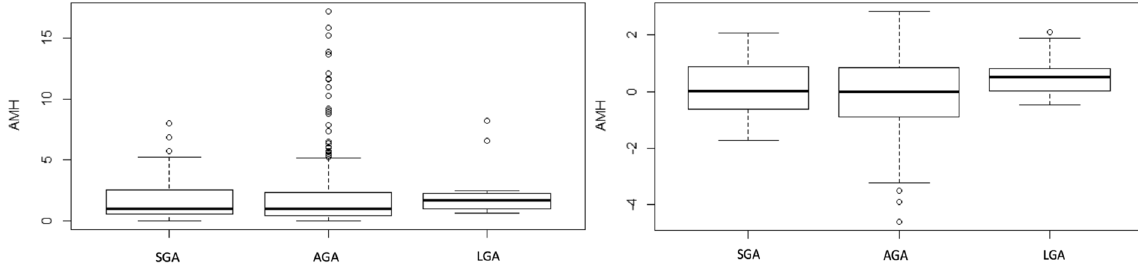
Figure 3. Boxplot for AMH distribution per